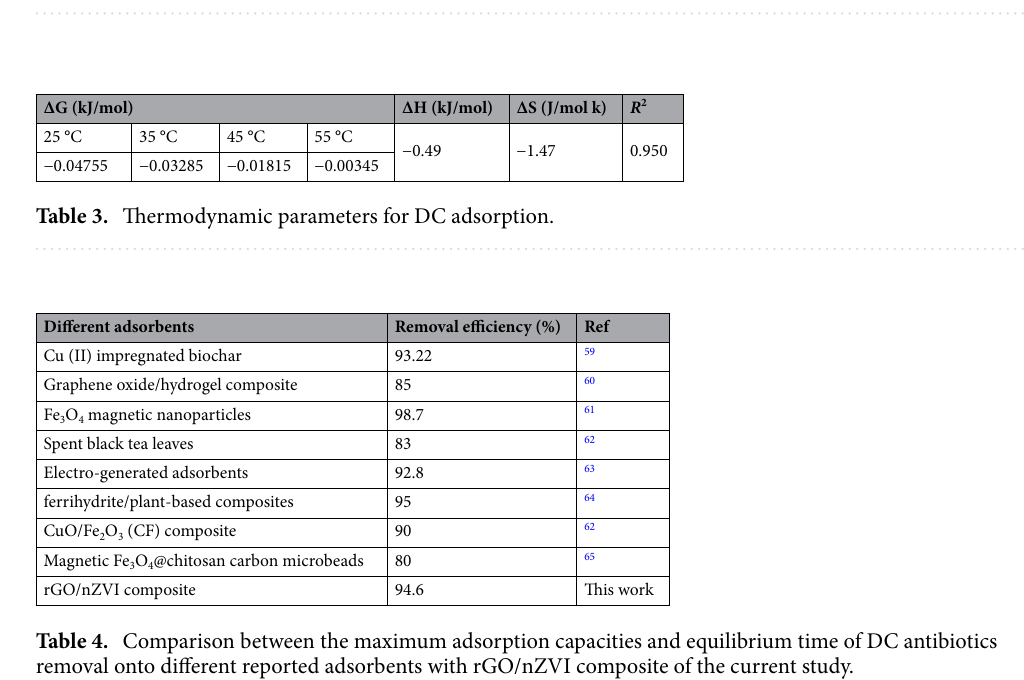
Table 2. Isotherm parameters for the adsorption of DC antibiotics onto rGO/nZVI composite .